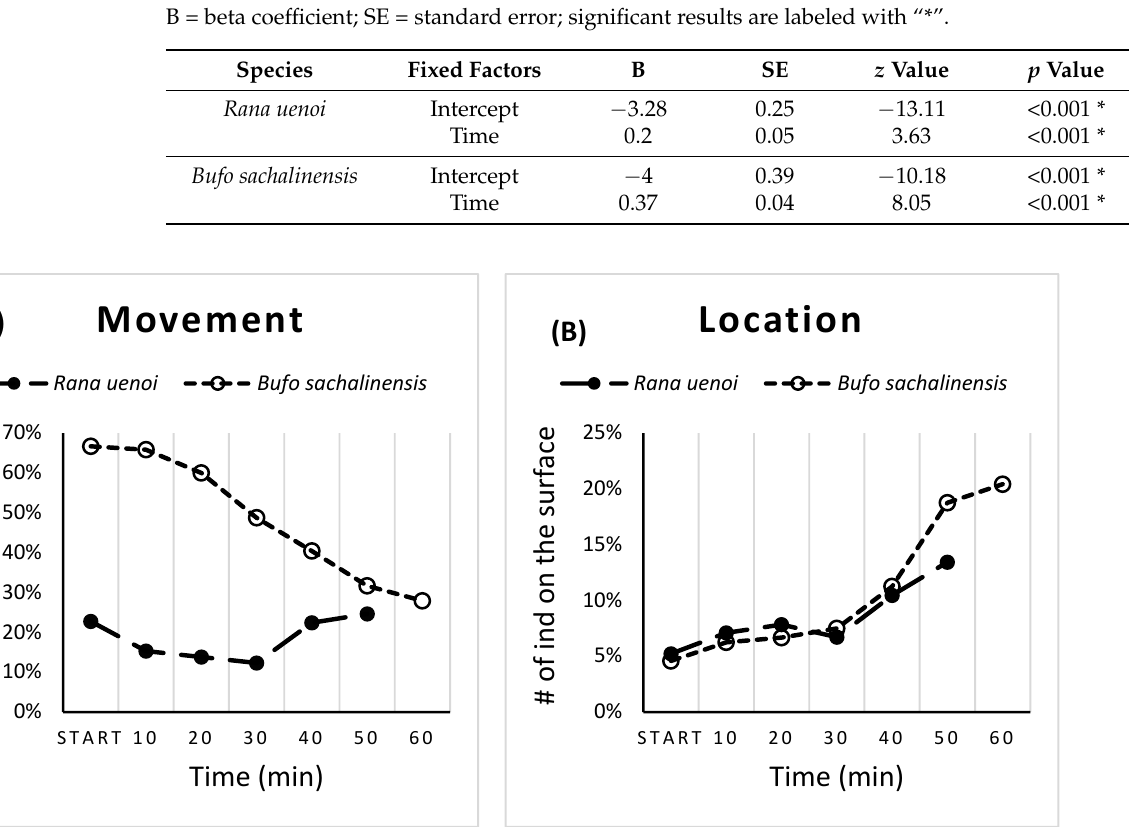
Figure 4. The frequency changes of movement ( A ) and location ( B ) of Rana uenoi (close circle; n = 270) and Bufo sachalinensis (open circle; n = 240) over time.